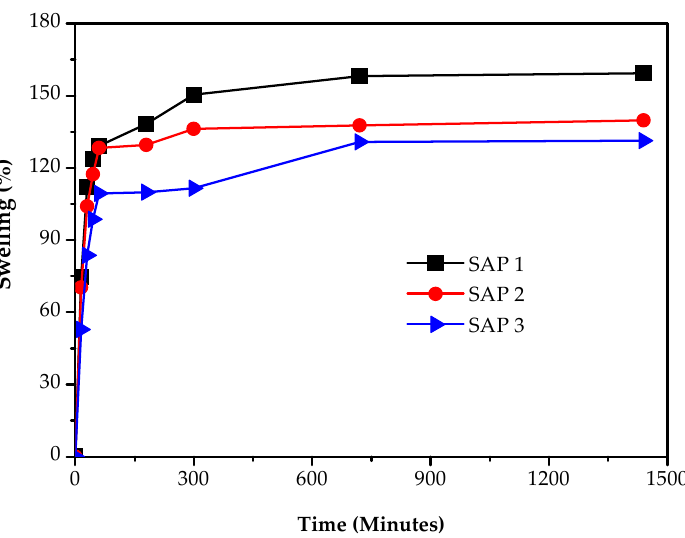
Figure 3. Effect of chitosan concentration on water absorption in manufacturing acrylic acid-based superabsorbent.